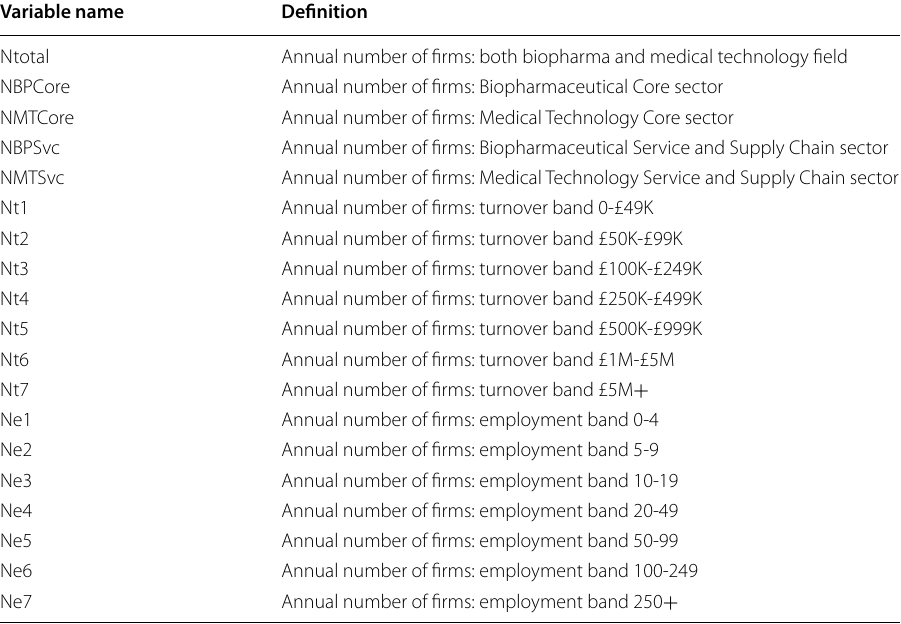
Table 2 Variables and definitions: Annual irm numbers